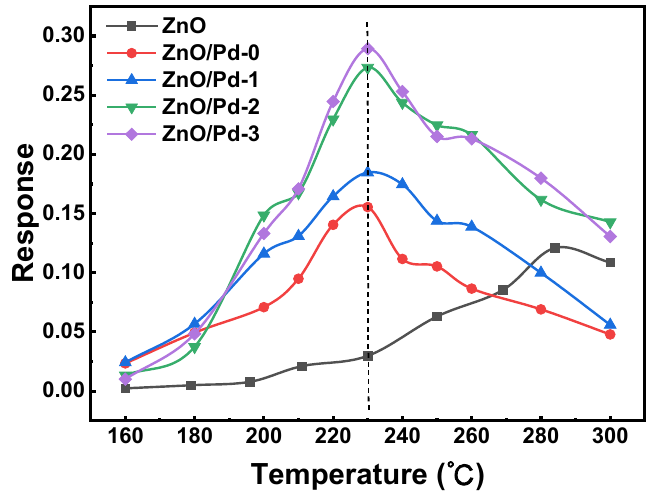
Figure 3. Response of ZnO, ZnO/Pd-0, 1, 2 and 3 to 500 ppm CH 4 at different temperatures.